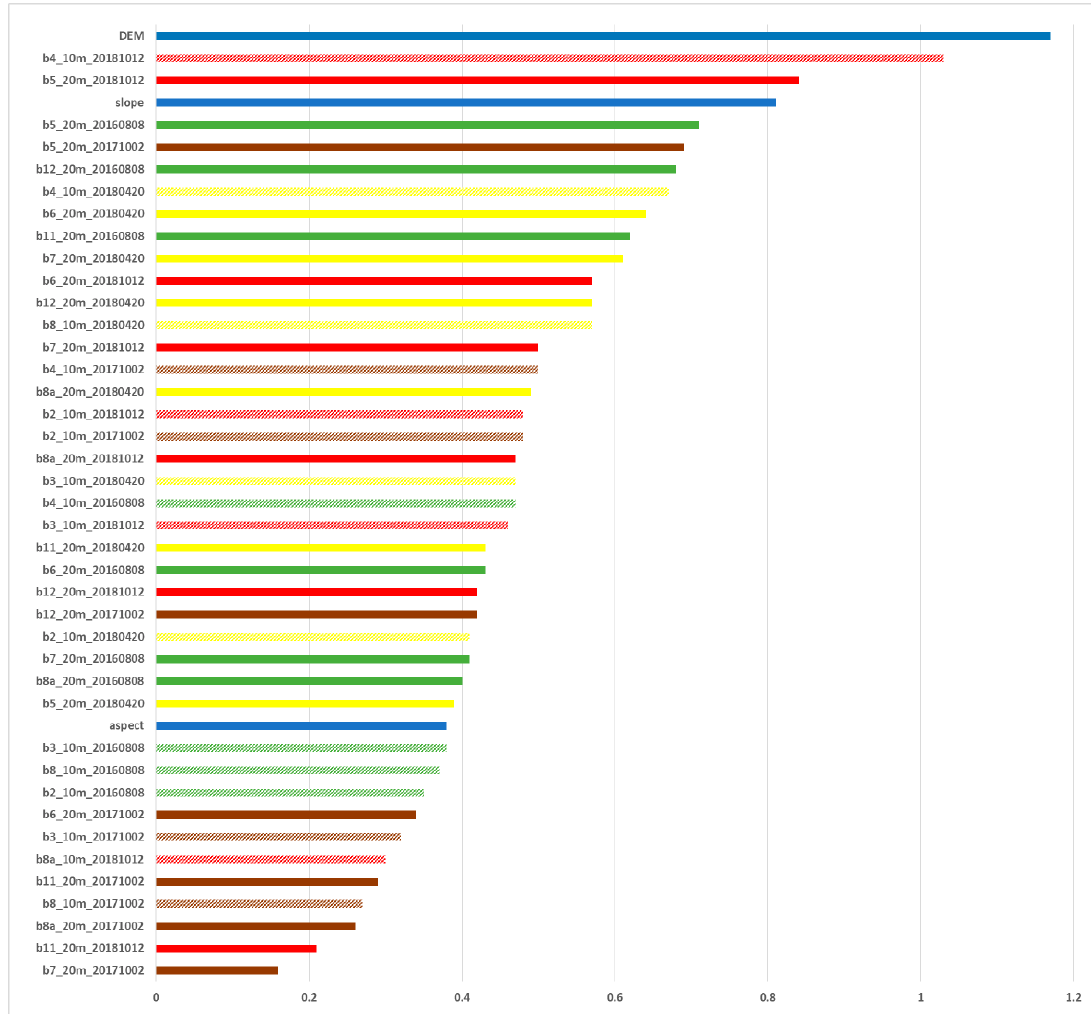
Figure 8. The normalised variable importance for broadleaf tree species classified using the combination of multi-temporal Sentinel-2 data and topographic features: DEM, slope and aspect. The variables are coloured according the Sentinel-2 acquisitions: Yellow indicates Spring (20 April), green—Summer (8 August), brown—early Autumn (2 October), red—mid-Autumn (12 October) and blue indicates the topographic features. The solid colours refer to 10 m spatial resolution bands and the dash pattern refers to 20 m spatial resolution